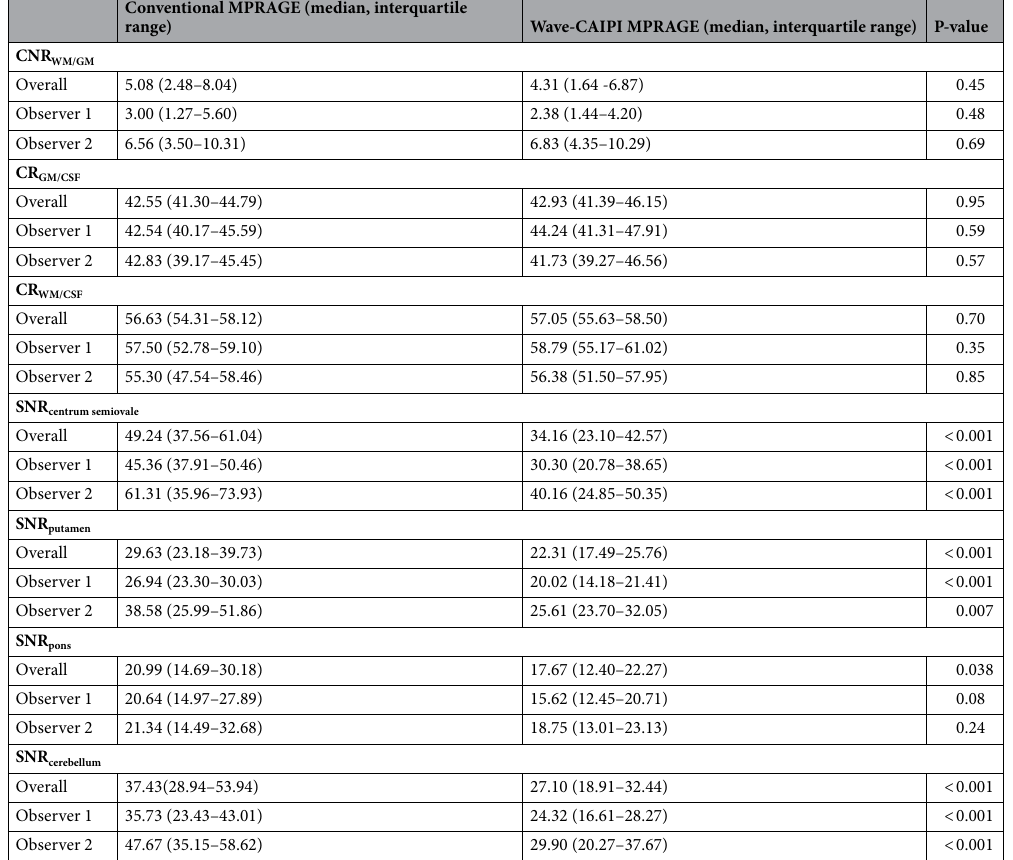
Table 3. Quantitative image analysis. CNR contrast-to-noise ratio, CR contrast rate, GM gray matter, MPRAGE magnetization-prepared rapid gradient echo, SNR signal-to-noise ratio, wave-CAIPI wave-controlled aliasing in parallel imaging, WM white